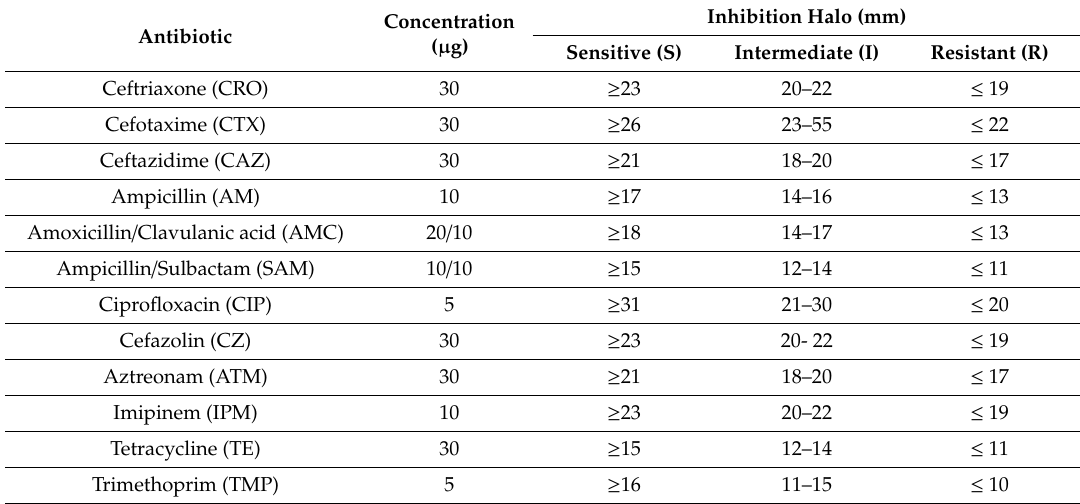
Table 1. Antibiotics used in the susceptibility tests and the break-points for resistance and susceptibility.